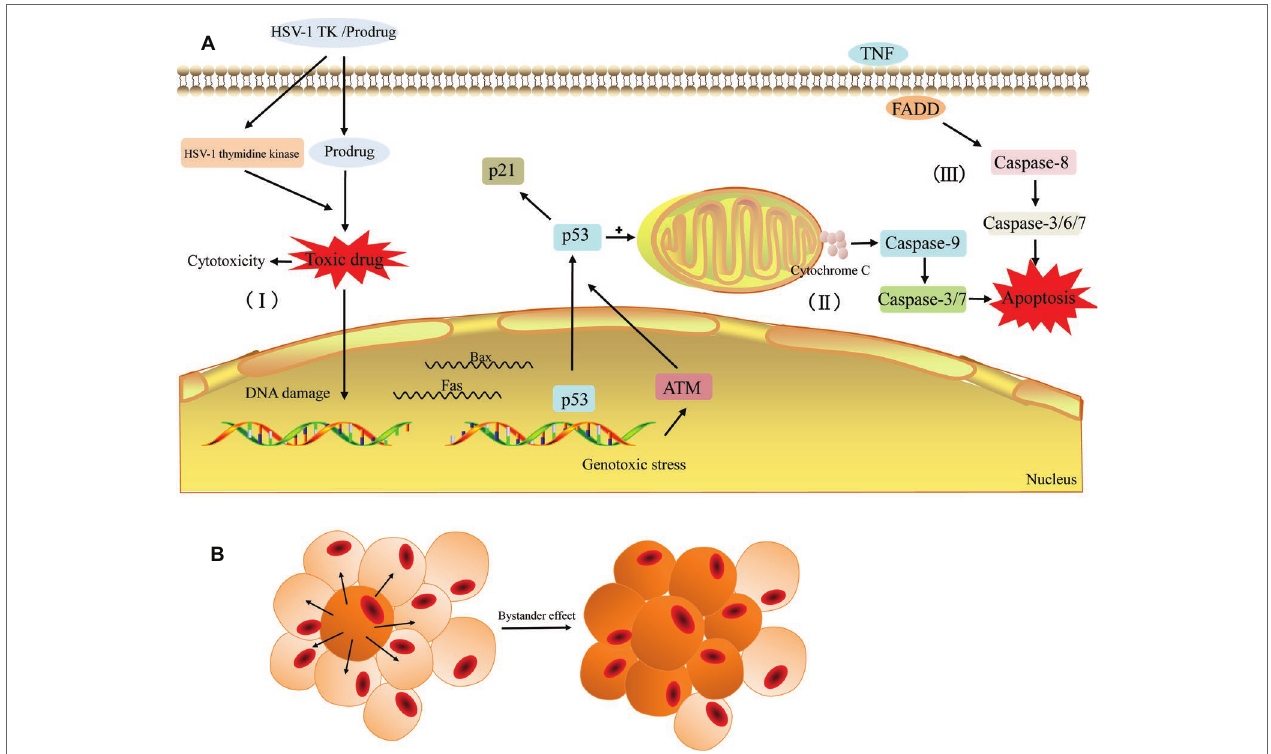
FIGURE 3 | General principle of the HSV-TK suicide gene system. (A) The HSV-TK/prodrug system induced cytotoxicity and apoptosis in tumor cell. (I) The HSV-1 TK gene coding for thymidine kinase is delivered to the target cell. The expression of HSV-1 thymidine kinase and cellular kinases allows a prodrug (GCV) to be activated as the toxic drug (GCV-TP) in the cell and damage the DNA of the target cell. (II) Gene therapy induces endogenous apoptosis by activating p53 signaling pathway in the target cell. (III) Gene therapy induces exogenous apoptosis. (B) The bystander effect induces the death of adjacent